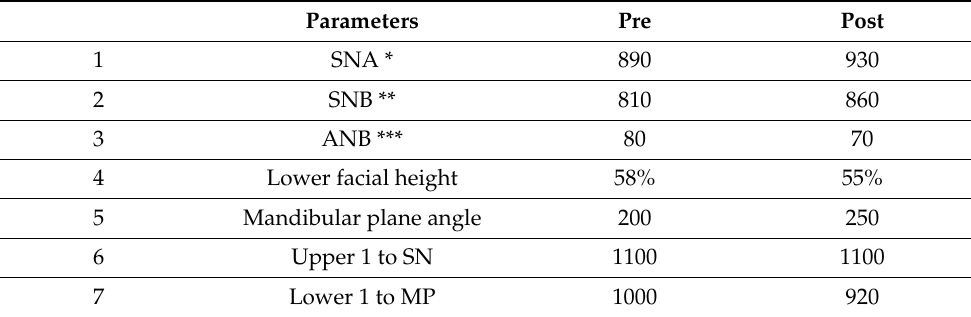
Table 3. Cephalometric pre- and post-treatment values in patient No